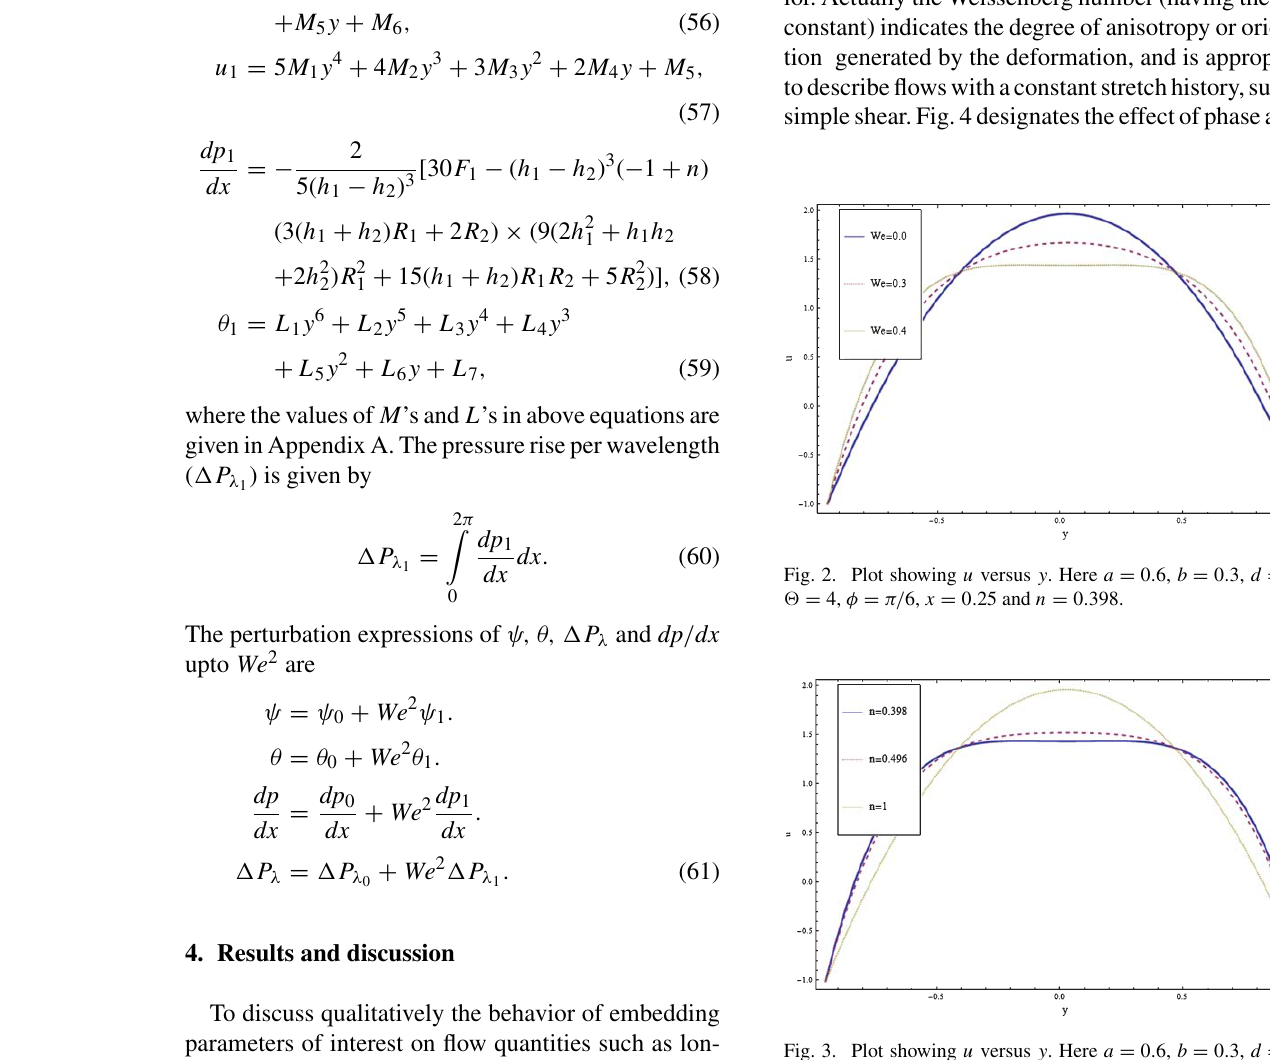
Fig. 3. Plot showing u versus y . Here a = 0 . 6, b = 0 . 3, d = 1 . 1, (cid:14) = 4, φ = π/ 6, x = 0 . 25 and We = 0 .